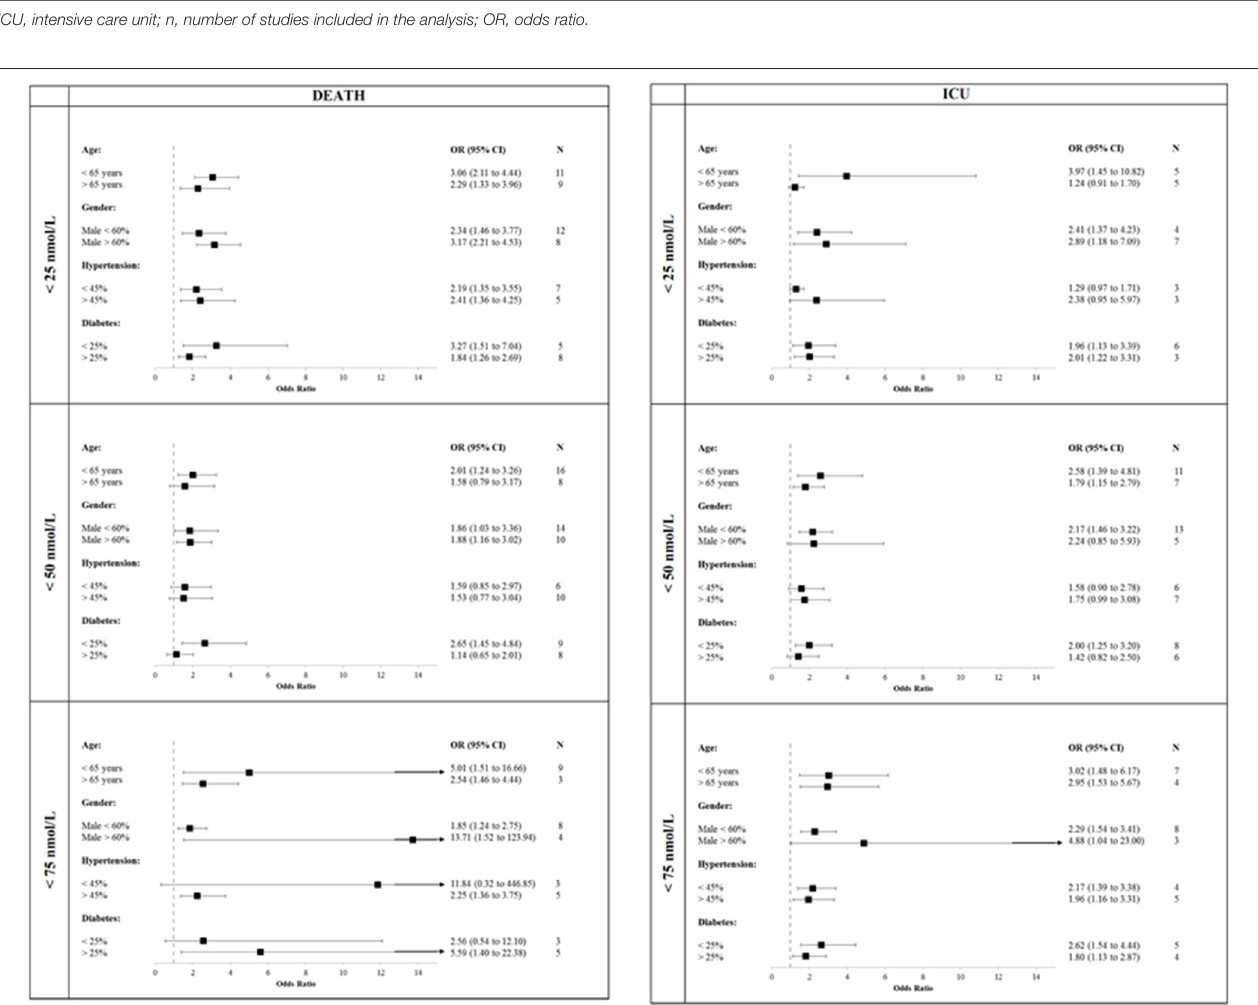
assessed at the time of hospitalization, are associated with greater COVID-19 severity, and impact on the degree of respiratory distress (e.g., requiring ICU admission) and COVID- 19 related